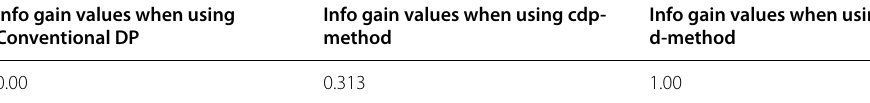
Table 8 Information gain values for conventional DP, cdp-method [5] and d-method